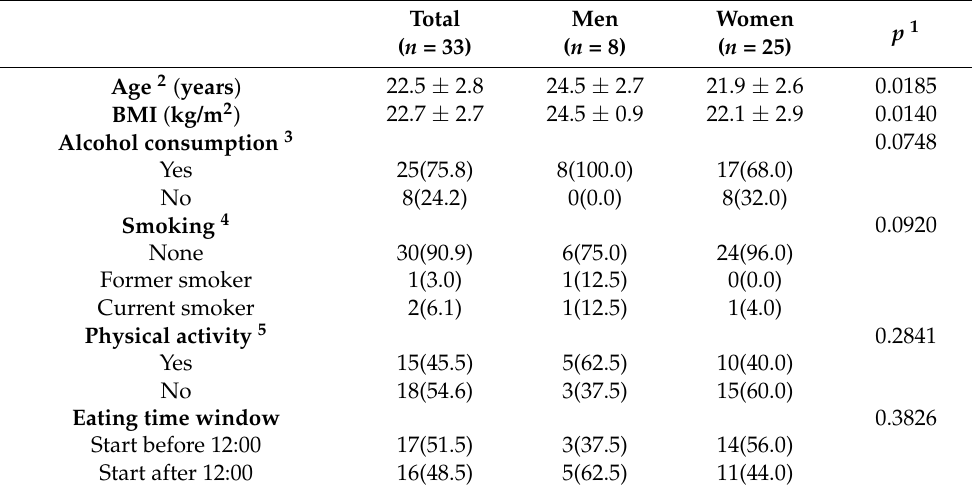
Table 1. The basic characteristics of the time-restricted eating